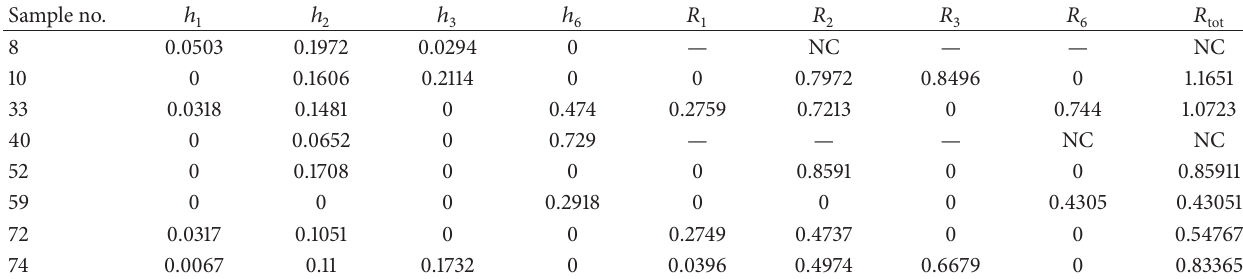
Table 8: 𝑅 values calculated for some tot